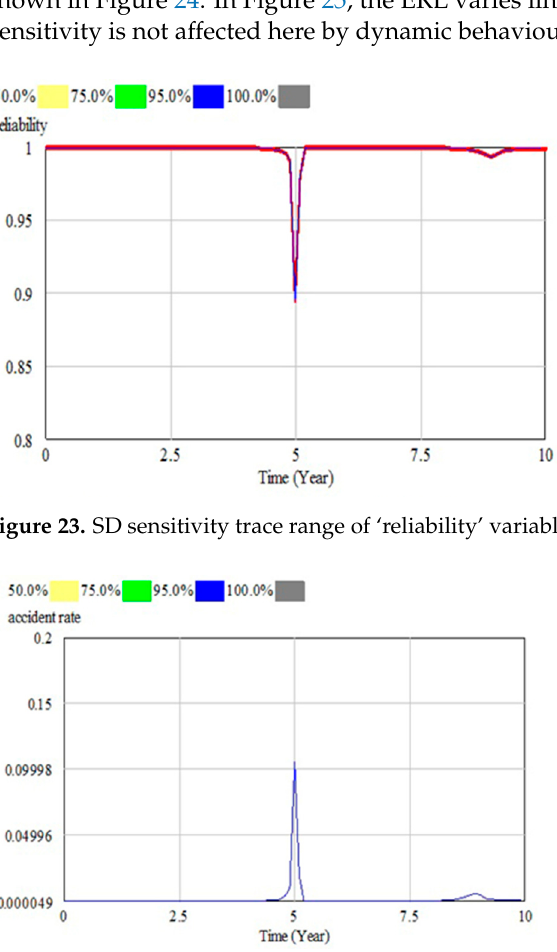
Figure 24. SD sensitivity trace range of ‘accident rate’ variable.